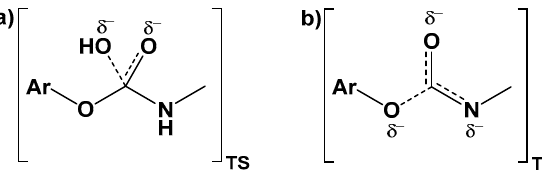
Figure 8. Proposed transition states on two possible reaction pathways for hydrolysis of an